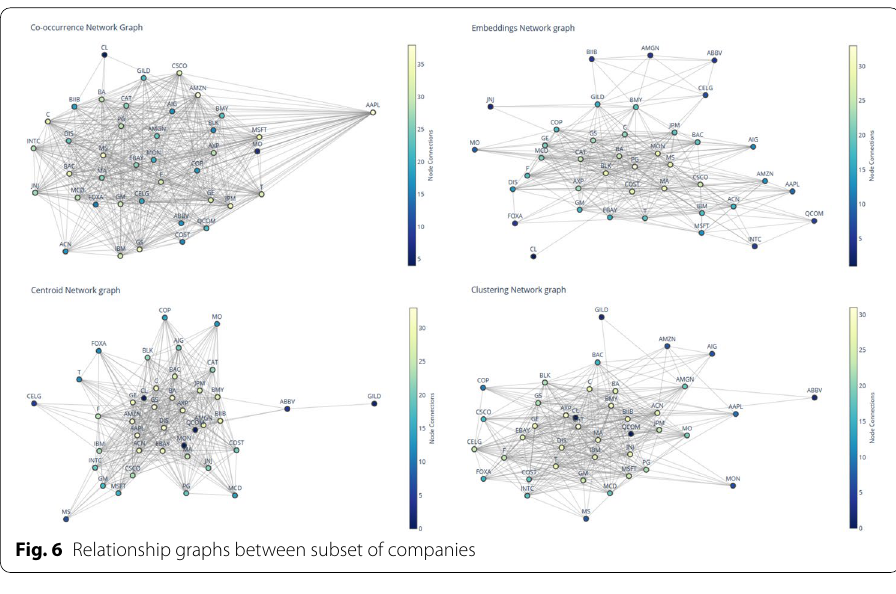
Fig. 6 Relationship graphs between subset of companies